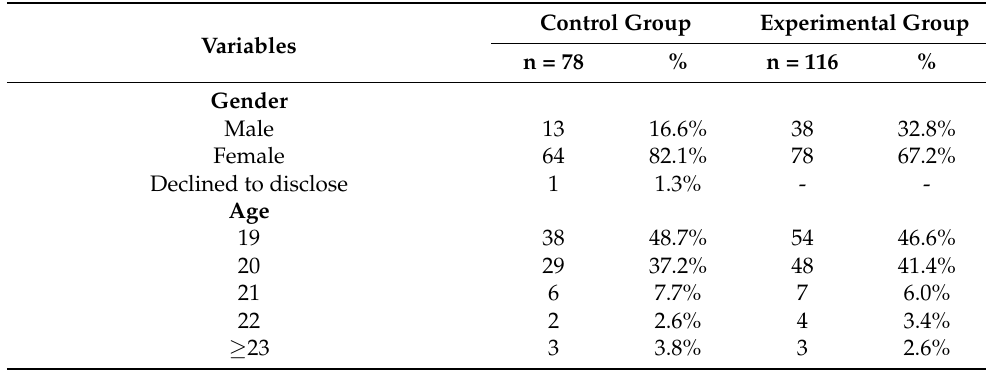
Table 2. Basic demographic of survey